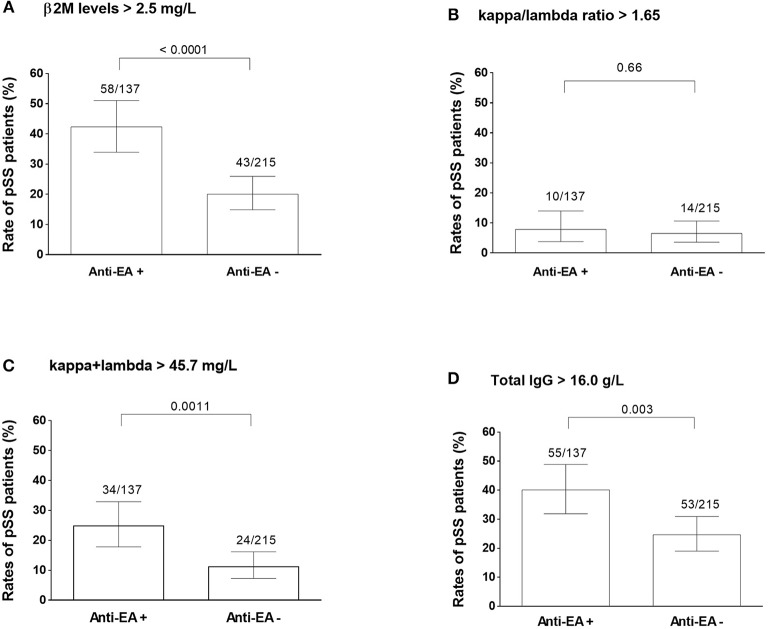
PSS activity markers in anti-EA positive and anti-EA negative patients. Abnormally increased beta-2 microglobulin levels (A), kappa and lambda light chain ratios (B), summary kappa and lambda light chain levels (C), and total immunoglobulin G levels (D) are compared between anti-EA positive and negative pSS samples. Each column represent the percentage of cases having higher value than the threshold written on the top of each graph.